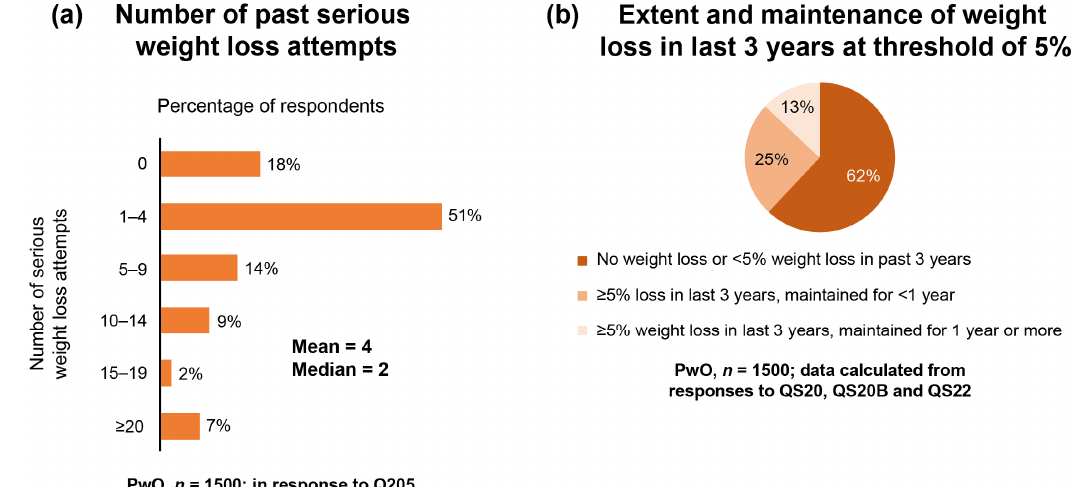
Figure 2. Weight loss efforts and maintenance. ( a ) Number of serious past weight loss attempts by PwO; ( b ) PwO extent and maintenance of weight loss in the last 3 years at a threshold of 5% of total body weight. PwO, people with obesity.